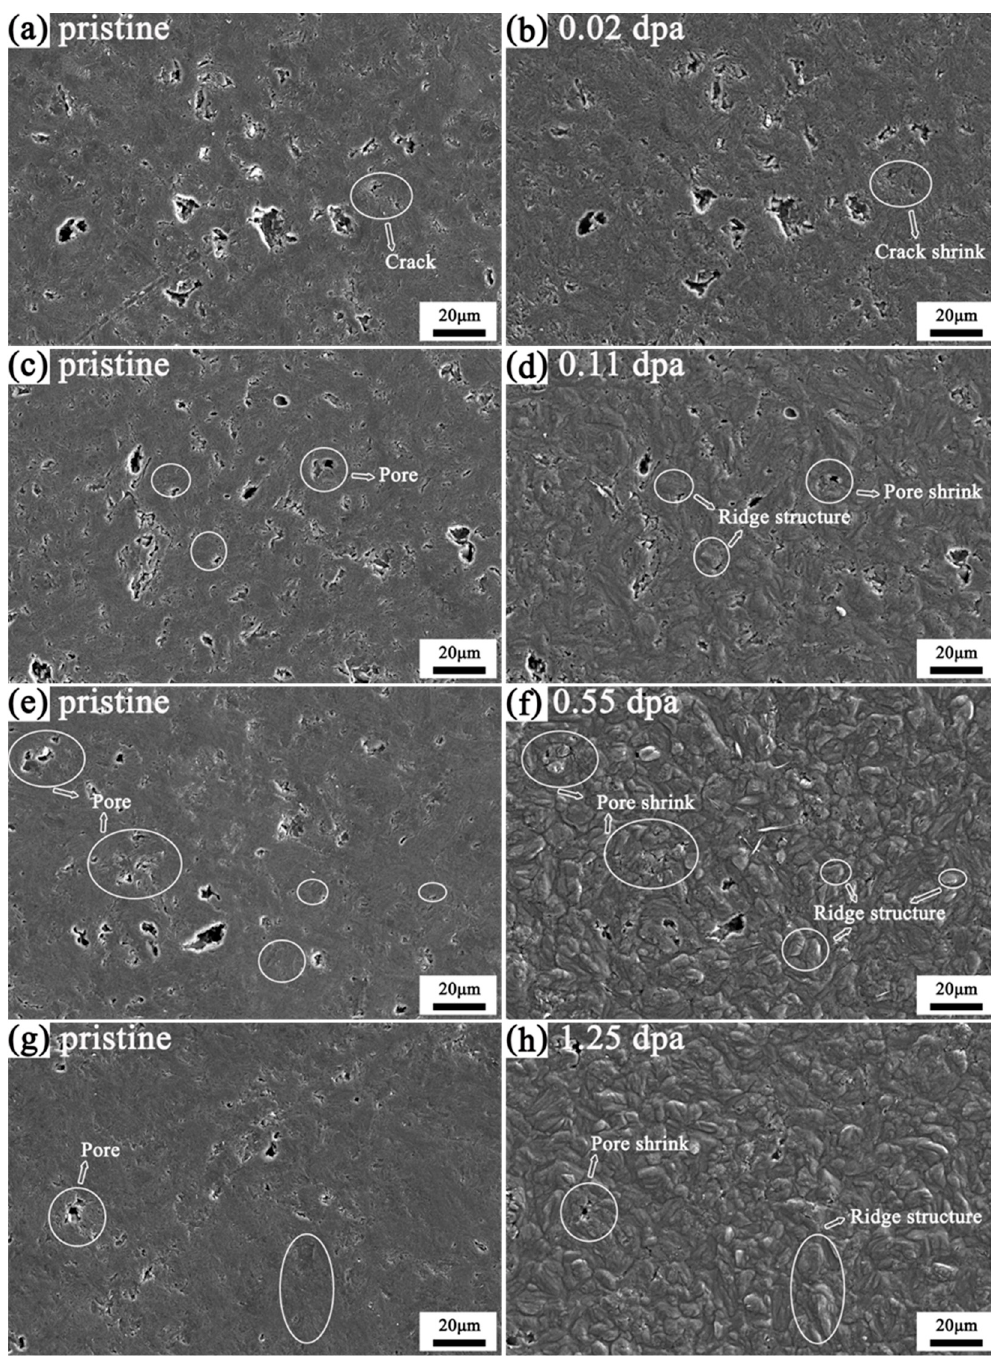
Figure 1. SEM images of NG before ( a , c , e , g ) and after irradiation at a surface irradiation dose of 0.02 dpa ( b ), 0.11 dpa ( d ), 0.55 dpa ( f ) and 1.25 dpa ( h ).